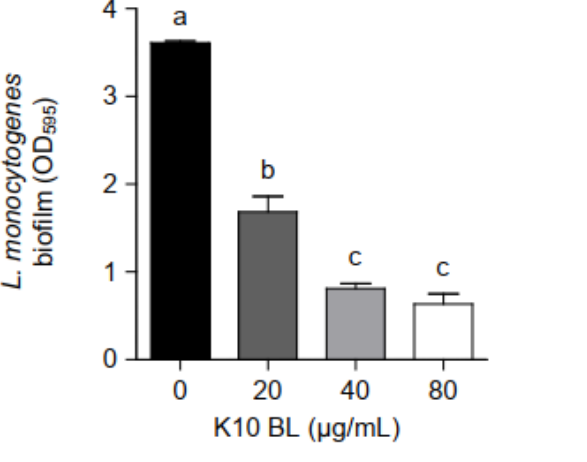
Figure 1. Inhibitory effect of P. acidilactici BLs on L. monocytogenes biofilm formation. K10 BL ( A ) or HW01 BL ( B ) (0, 20, 40, and 80 µ g/mL) was preincubated at 37 ◦ C for 3 h in a 96-well culture plate, after which L. monocytogenes (1 × 10 7 CFU/mL) was added and incubated at 37 ◦ C for an additional 24 h. L. monocytogenes biofilm formation was assessed by crystal violet staining. The results are represented as the means ± standard deviations from three independent experiments ( p < 0.05). Significant differences between treatment with K10 BL or HW01 BL are expressed with different letters